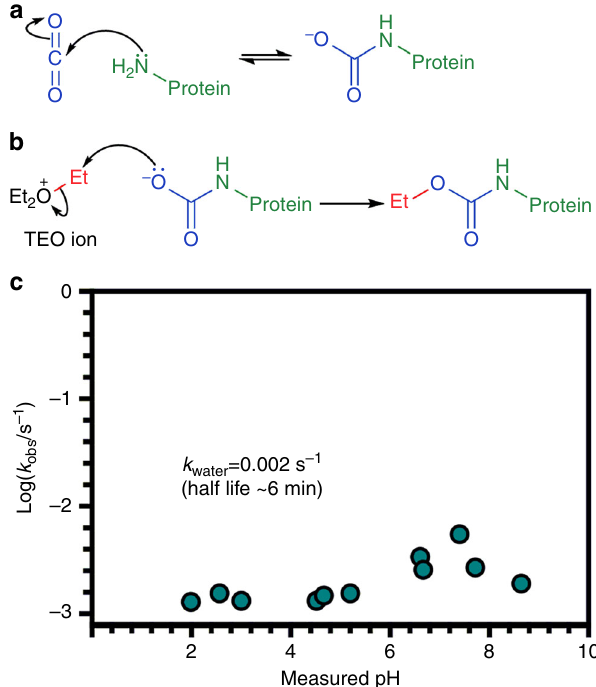
Fig. 1 Protein carbamate formation and trapping with TEO. a Carbamates form through the reversible reaction between CO 2 and neutral amine groups. b Proposed trapping mechanism of a protein carbamate with TEO. TEO transfers an ethyl group (red) to the anionic carbamate derived from CO 2 (blue) and protein primary amine (green). c Observed pseudo fi rst- order rate constants, k obs , for the hydrolysis of TEO plotted as a function of pH (where k obs = k water + [ k hydroxide. K W /10 – pH